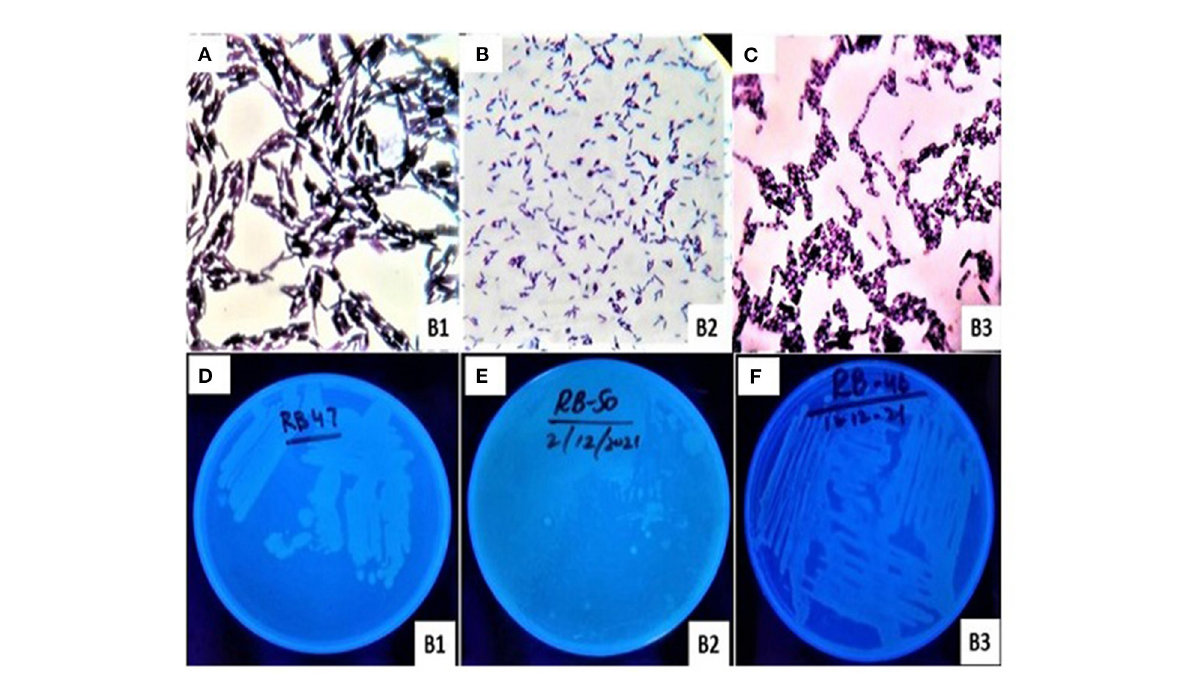
FIGURE1 Morphological characterization of bacterial isolates (B1, B2, and B3) in (A–C) and photographs under ultraviolet radiations in (D–F) , respectively.